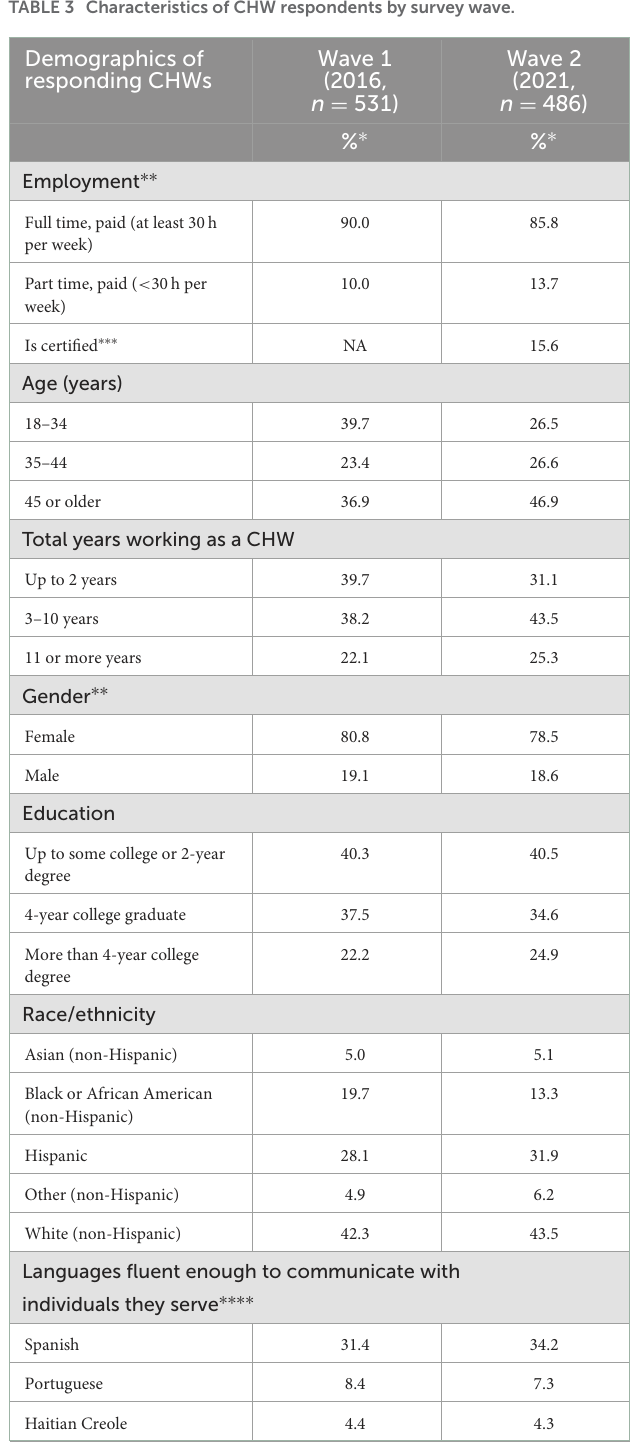
TABLE 3 Characteristics of CHW respondents by survey